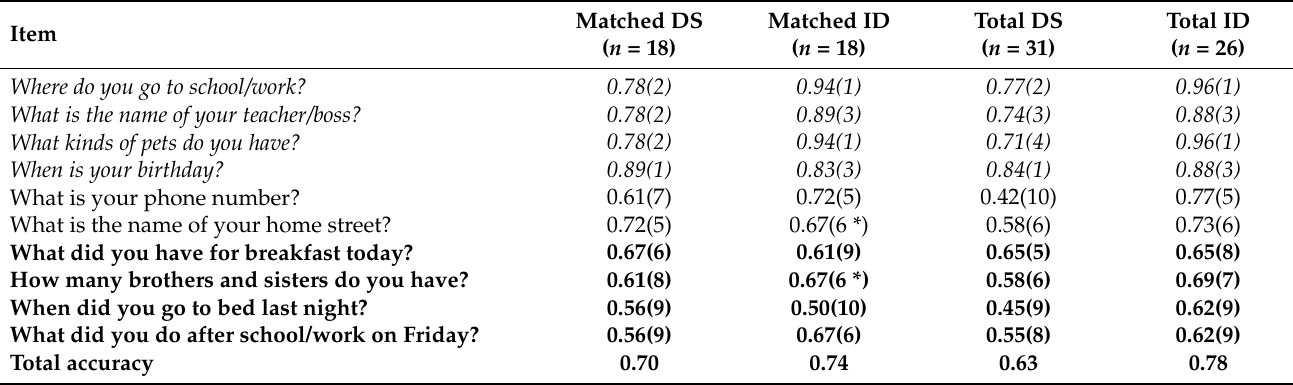
Table 3. Accuracy (rank order in parentheses) on Everyday Memory questions for the matched subsamples and the whole samples of mixed ID and DS